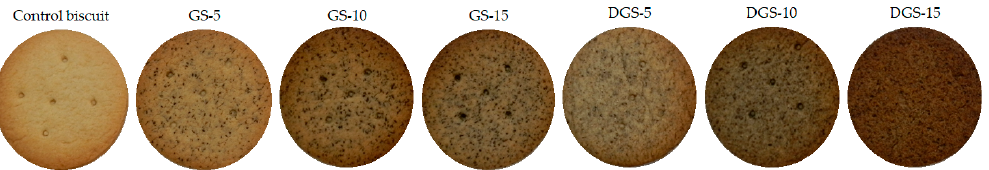
Figure 1. The appearance of wheat-based biscuits (control) with added ground chia seeds (GS) and defatted ground chia seeds (DGS) at 5, 10 and 15%.